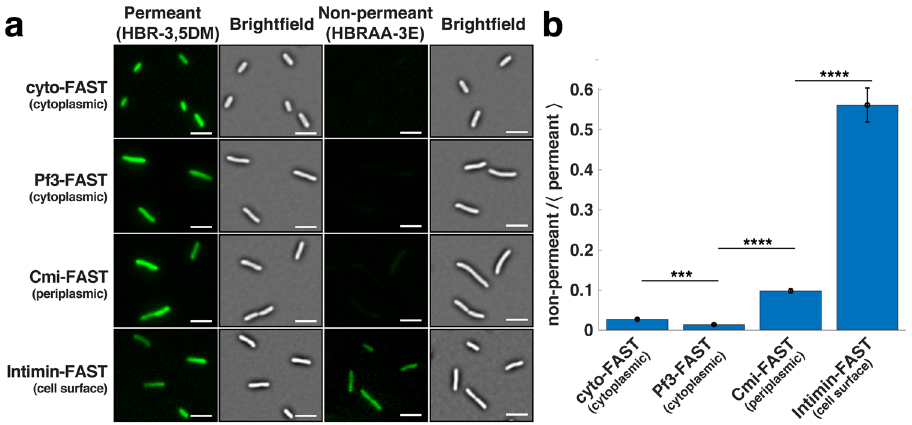
Figure 4. The outer membrane chimeric protein Intimin-FAST becomes fluorescent upon binding to the non-membrane permeant fluorogen HBRAA-3E. ( a ) Brightfield (right) and TIRF (left) images of exponentially growing (OD 600 = 0.7) E. coli harbouring FAST constructs revealed by the permeant (HBR-3,5DM) and non- permeant (HBRAA-3E) fluorogens. From top to bottom: cyto-FAST constitutively produced freely in the cytoplasm from the plasmid pZE1R-FAST; Pf3-FAST exposed on the cytoplasmic leaflet of the inner membrane produced from the plasmid pPf3-FAST; Cmi-FAST exposed on the periplasmic leaflet of the inner membrane produced from the plasmid pCmi-FAST; and intimin-FAST exposed at the cell surface produced from pNeae2- FAST, all in presence of IPTG. Cells were deposited on a 1% agarose LB pad containing either 20 µM of HBR-3,5DM or 40 µM of HBRAA-3E with 0.5 mM IPTG when necessary. The background of the fluorescence images has been subtracted. For each construct, fluorescent images obtained with the permeant and non- permeant fluorogens are displayed with the same contrast. Scale bar is 5 µm. ( b ) The signal of the non-permeant (HBRAA-3E) fluorogen divided by the average of the permeant (HBR-3,5DM) fluorescent signal for the different constructs: cyto-FAST (n = 318 for HBR-3,5DM; n = 55 for HBRAA-3E); Pf3-FAST (n = 211 for HBR- 3,5DM; N = 198 for HBRAA-3E); Cmi-FAST (n = 214 for HBR-3,5DM; n = 160 for HBRAA-3) and intimin-FAST (n = 99 for HBR-3,5DM; n = 89 for HBRAA-3E). Error bars represent standard errors. Statistical analysis was performed using unpaired t-tests (***, p value < 0.001; ****, p value <